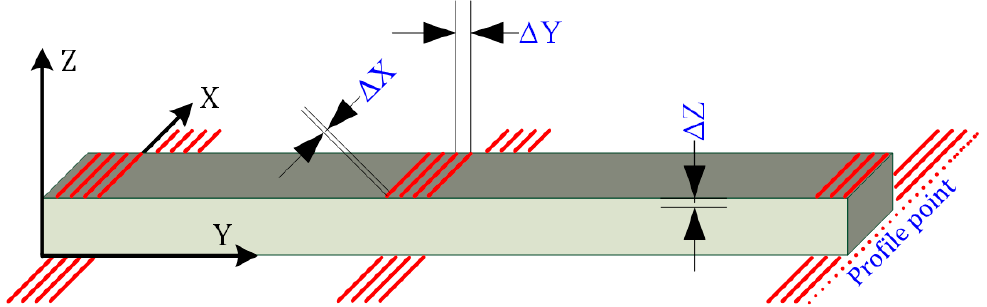
Figure 3. 3D imaging resolution described on the object.